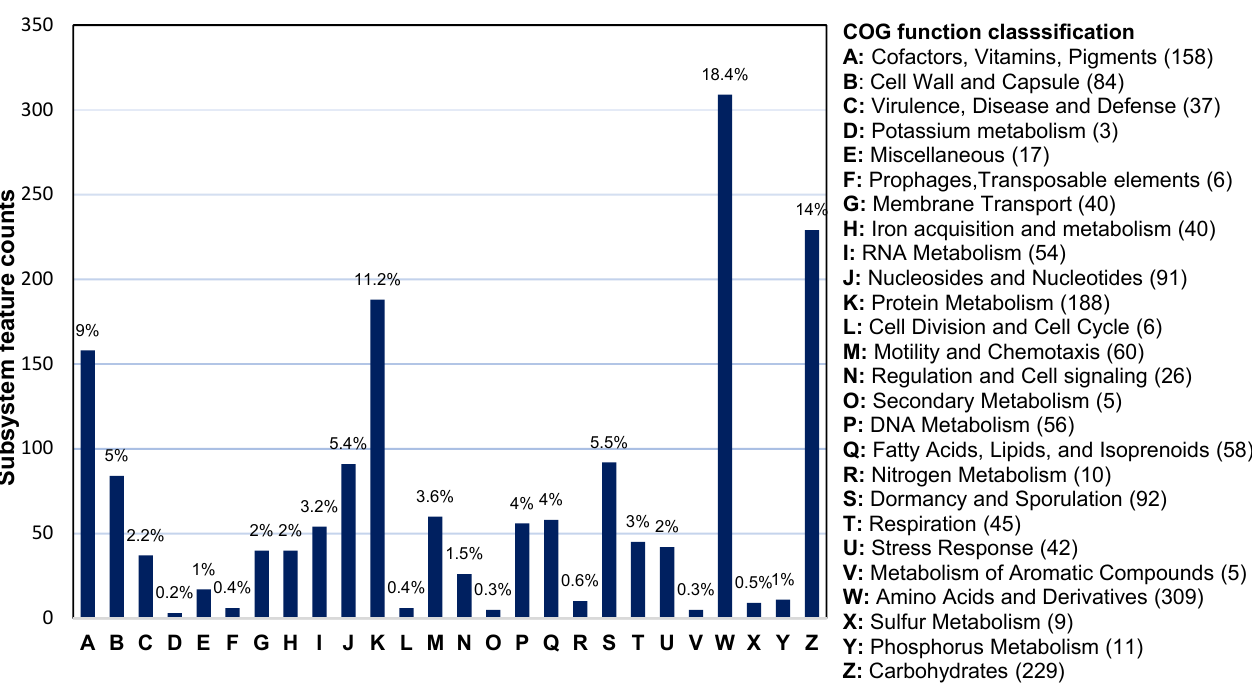
Figure 5. RAST subsystems categories and feature distribution of B. pumilus SF-4 genome. The percentage of category distribution is mentioned on each bar graph.